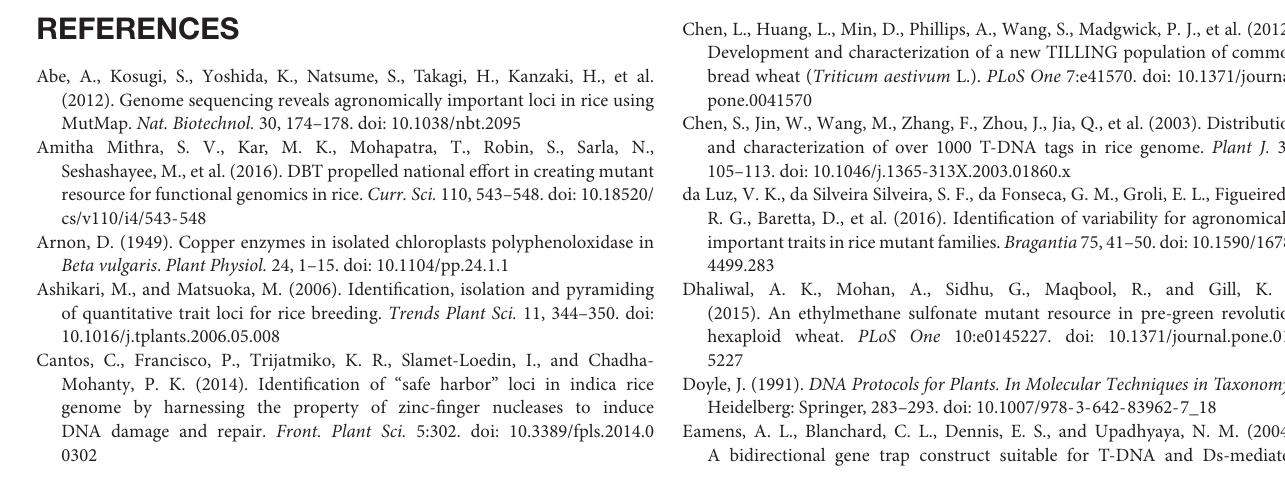
FIGURE S1 | Schematic representation of generation of mutant resources and the phenotyping of 541 mutants. FIGURE S2 | Generation (A) , maintenance (B–D) , and storage (E,F) of the EMS mutant resources of Nagina 22. FIGURE S3 | (A) Chromosome wise distribution of SSR markers chosen for assessment of genomic similarity of the mutants with Nagina 22; (B) Polymorphism survey of the WT, Nagina 22 with a indica variety IR 64; (C) : Genotyping of the mutants with HvSSR 8-29 and with HvSSR 6-56. FIGURE S4 | Schematic illustration of the mutant database architecture. FIGURE S5 | Schematic representation of the development of Nagina 22 genic sequence resource using the whole genome sequencing data of Nagina 22 and four mutants. (A) Flow chart of the sequence development; (B) methodology adopted to assemble polished Nagina 22 sequence. TABLE S1 | Mutant resources available in rice across the globe. TABLE S2 | Details of the SSR primers used for assessment of genomic similarity of the mutants with Nagina 22. HvSSRs are indicated in green font. TABLE S3 | Descriptive statistics of major morphological traits in the rice EMS mutant garden of Nagina 22 in Kharif 2016 and Kharif 2017 at New Delhi. TABLE S4 | List of 81 genes used for reverse genetic mapping of the stay-green trait